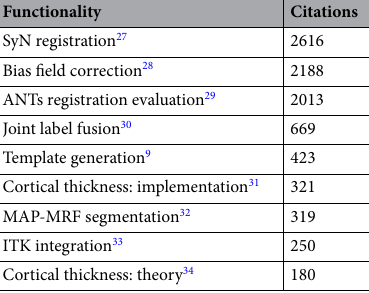
Table 1. The significance of core ANTs tools in terms of their number of citations (from October 17,